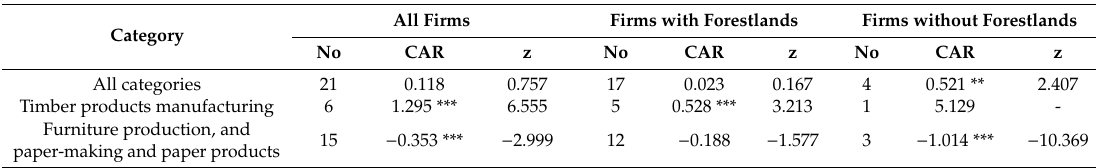
Table 2. Results of testing policy